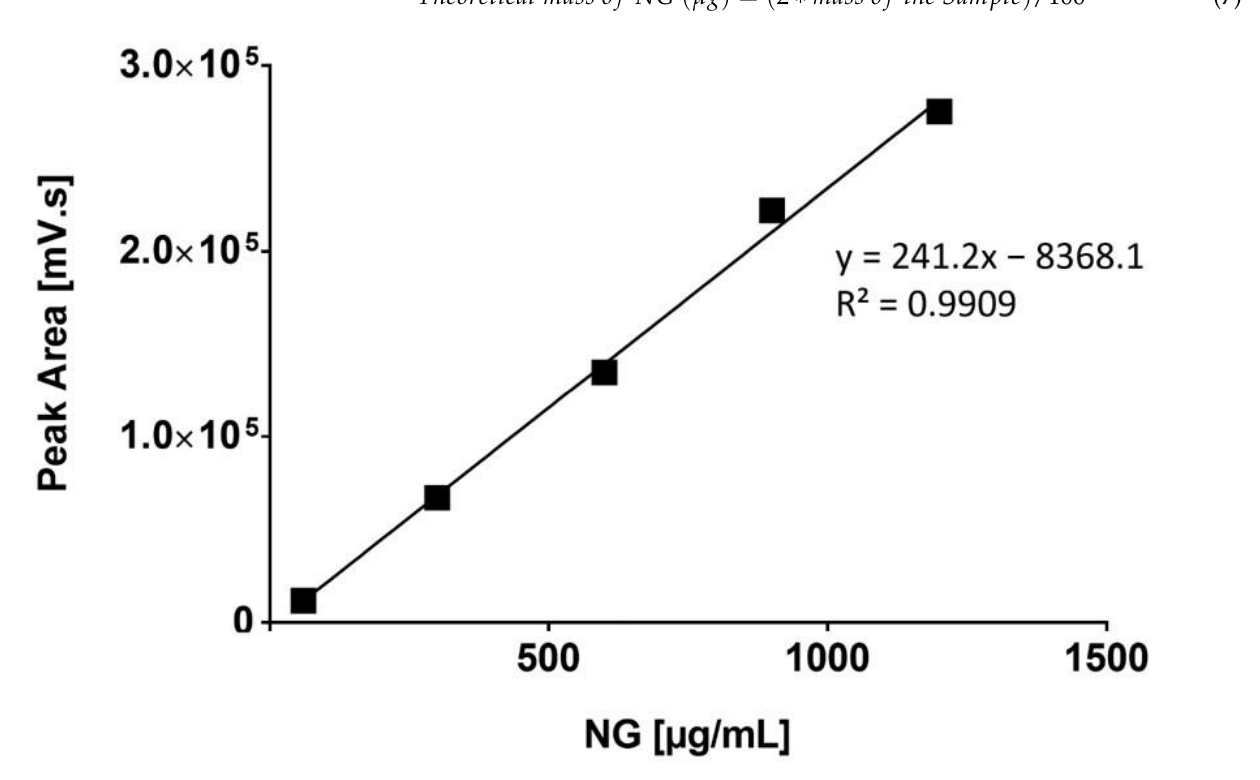
Figure 1. Calibration curve of NG solutions of concentration range from 60 µ g/mL to 1200 µ g/mL. Standard deviations are not noticeable as <1.